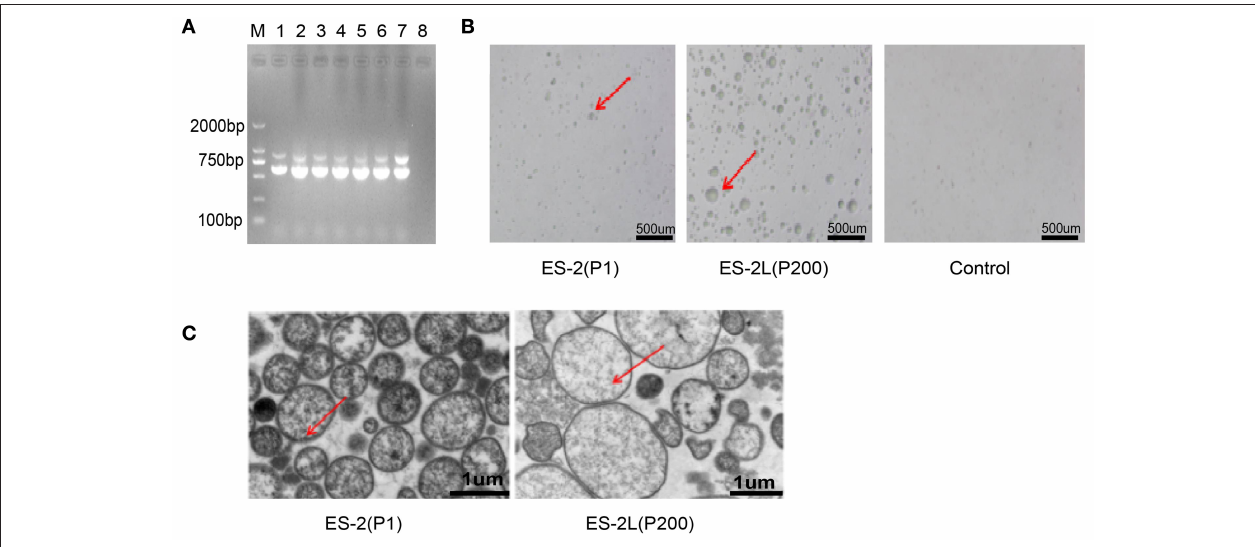
FIGURE 1 | (A) Detection of Mycoplasma hyopneumoniae -specific P36 (948 bp) and 16S RNA (627 bp) genes for the different passage strains: M, DNA marker 2,000; lane 1, ES-2 (P1); lane 2, P40; lane 3, P80; lane 4, P120; lane 5, P160; lane 6, ES-2L (P200); lane 7, positive control; lane 8, negative control. (B) Morphological observation of strain ES-2L and ES-2 on solid medium using a low-power microscope; the colonies of strain ES-2 and ES-2L showed the characteristics of rounded, distinct edges and centers with granules, as indicated by the red arrow. (C) Morphological examination of strains ES-2L and ES-2 observed by transmission electron microscopy, indicating that strain ES-2 had no cell walls, cell membranes were surrounded by capsules, and the cytoplasmic structure was loose; characteristics of strain ES-2L were similar to those of strain ES-2, but there were a few large-celled mutant individuals, as indicated by the red arrow.